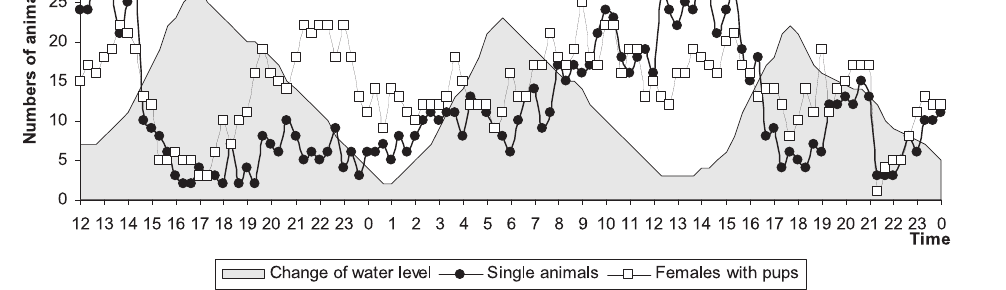
Fig. 4. Daily harbour seal haul out pat- tern and water level in the Ivanovskaya Bay in late June 1993 (based on data from Mishin et al.